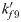
Activation of APC/C and substrate degradations.(A) Approximated steady-state protein levels from studies by Zhao et al. [40] using immunoblot analysis of PLK1T, CCNB1T, CDC20T CDH1T and PTTG1T in HeLa cells following release from synchronization in G1/S. Arrows mark points of comparison between in vitro and in silico data. (P, phosphorylated protein; T, total protein) (B) Immunoblot analysis as described in (A) by Zhao et al. [33] and including APC3T (i.e. APC/CT) and APC3P (i.e. APC/CP) but following release from M phase. (C) Simulation of APC/C ubiquitin ligase regulation including changes in PPase, APC/CP, APC/CT, PTTG1T, CDC20T, CDH1T, CCNBT, PLK1T and MPF kinase (CCNB1:CDK1). Boxed area is magnified. (P, phosphorylated protein; T, total protein). (D) Kinetics of CCNB1T levels from studies by Hein et al. [13] using HeLa cells expressing wild-type CDC20 or mutated CDC20 3SP (T55S, T59S, T70S) following release from synchronization in G1/S. (E) Simulated changes over time upon reducing PPase activity (kf9′) (i.e. PP2A) and associated changes in PPase, CDC20T, CCNB1T and MPF kinase (CCNB1:CDK1).